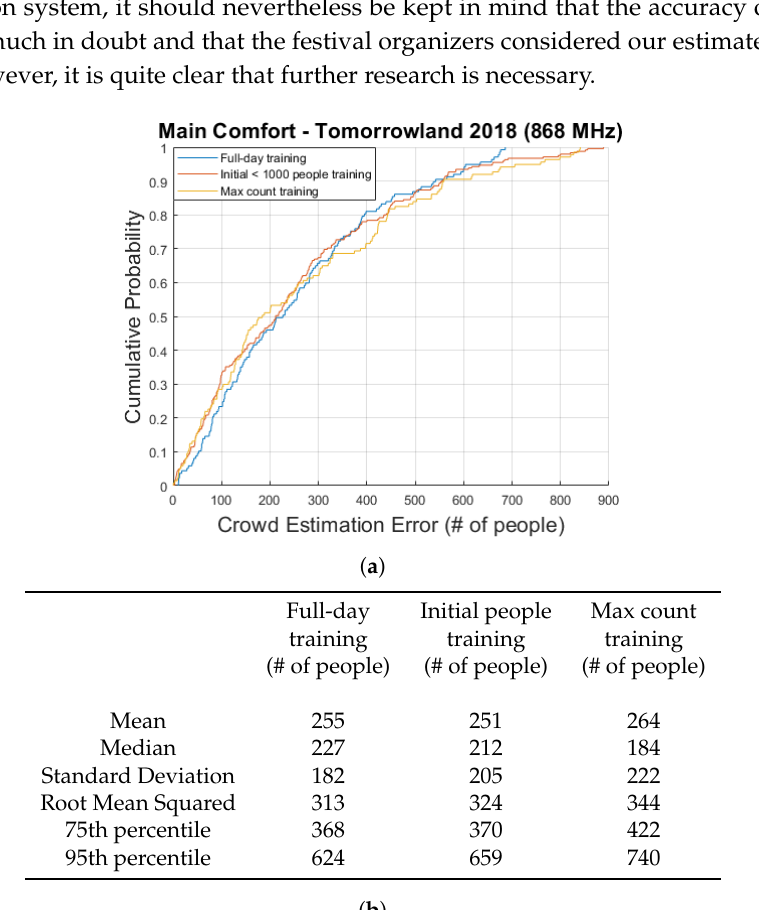
Figure 10. A cumulative distribution function plot comparing the obtained crowd estimation error values for the Main Comfort data for three different training approaches. ( a ) shows the actual plot while the table shown in ( b ) contains several key statistical